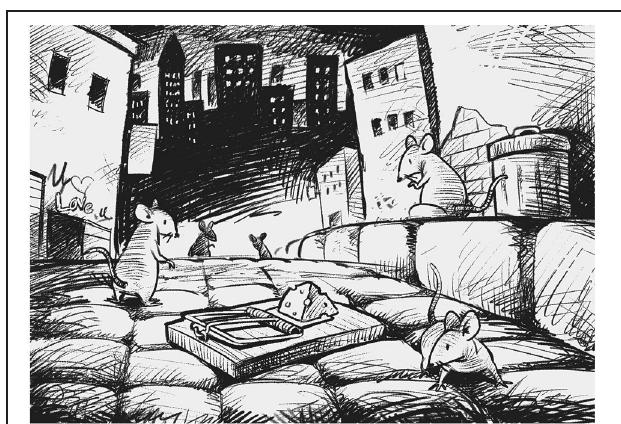
FIGURE 1 | A cartoon for illustrating the importance of contextual interpretation of items for choice behavior. Rodents usually avoid novel objects (cheese over the trap in this example) paired with a surrounding context to stay away from